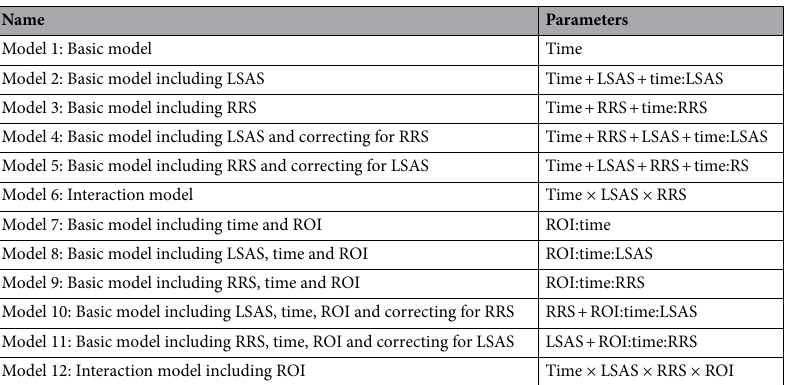
Table 5. Parameters included in the mixed models for the outcome measures (models 1–6: subjective stress, negative affect, state rumination; models 7–12: cortical oxygenation). In case of subjective stress, negative affect and heart rate, time was modelled as linear and quadratic term. Colons symbolize interaction effects. All included parameters except for time and region of interest (ROI) were z-standardized. In the models : means interaction effects, whereas × means interaction as well as the corresponding main effects (corresponding to the syntax of